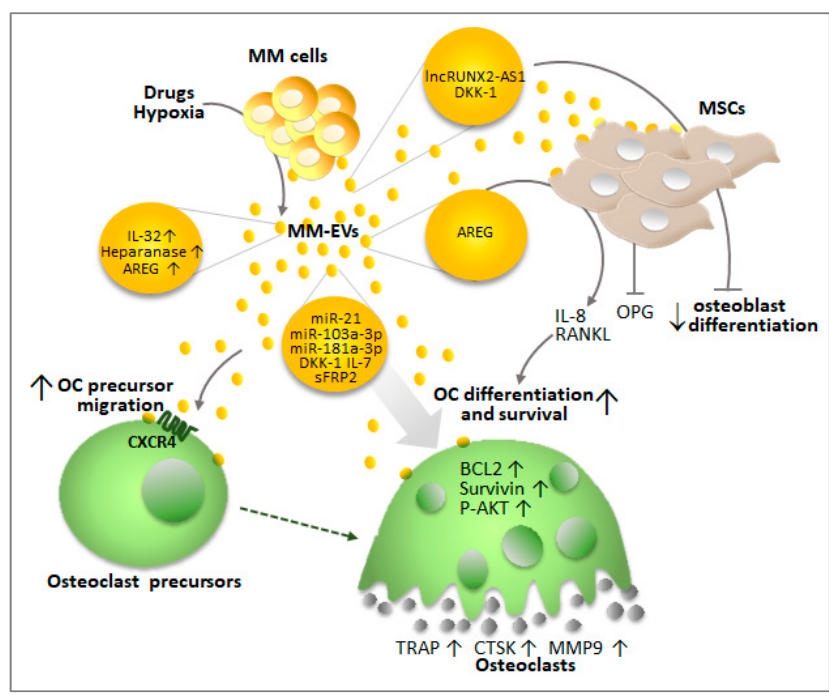
Figure 3. MM-EVs contribute to OC precursor migration, survival, differentiation, and osteolysis. They also inhibit osteoblast differentiation, either directly (through proteins, miRNA and lncRNAs) or by stimulating BM-MSCs. Details in the text.